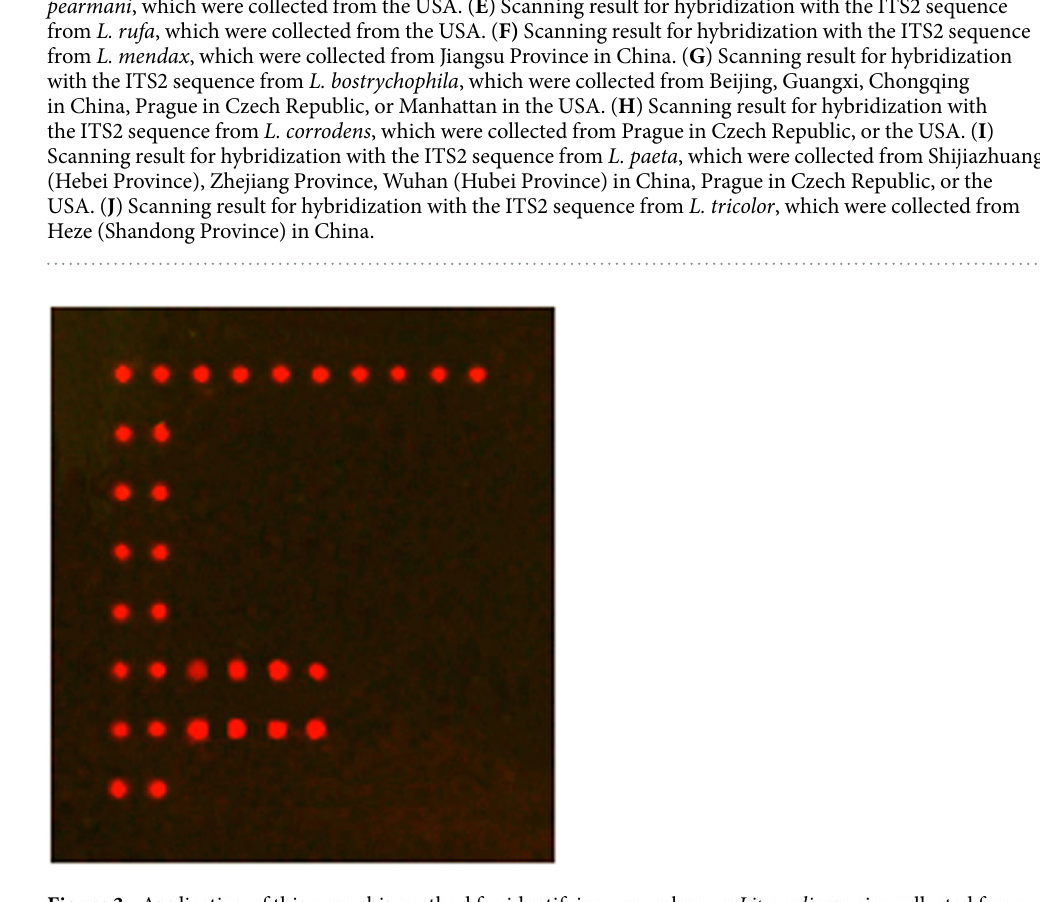
Figure 3. Application of this gene chip method for identifying one unknown Liposcelis species collected from Taian (Shandong Province). Scanning result shows that this unknown species is L. paeta